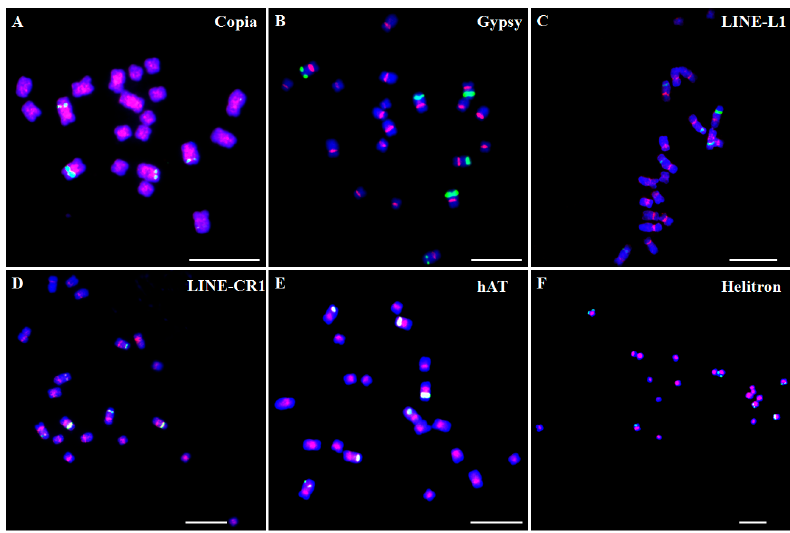
Figure 1. Distribution patterns of different transposable elements (TE) on chromosomes in Asparagus officinalis . The TE sequences were labeled with Texas Red (red signal), whereas 45S rDNA was labeled with Chroma Tide Alexa Fluor 488 (green signal), and the chromosomes were counterstained with DAPI (blue). ( A ) Ty1-copia; ( B ) Ty3-gypsy; ( C ) LINE-L1; ( D ) LINE-CR1; ( E ) hAT; ( F ) Helitron. The fluorescence in situ hybridization (FISH) images were captured with an ANDOR CCD camera under an Olympus BX63 fluorescence microscope. Bars = 10 µm.